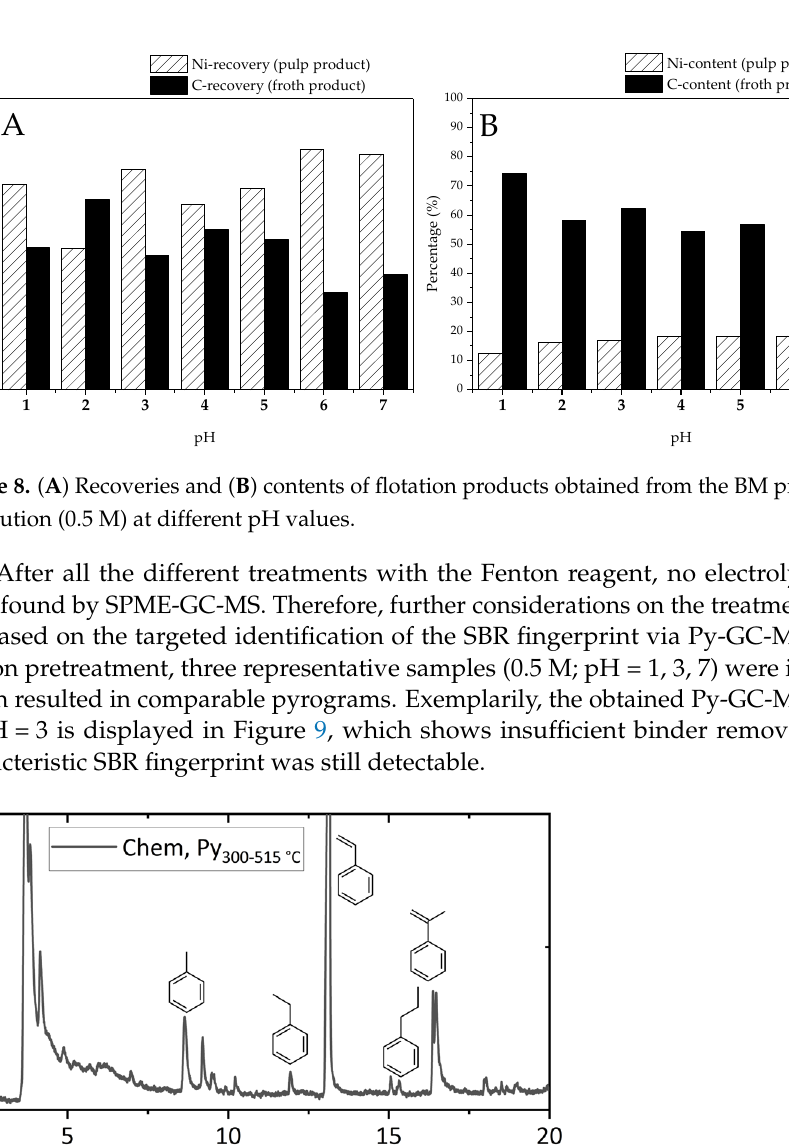
Figure 10. Magnified Py-GC-MS pyrograms of 4 different pyrolysis temperatures (200, 300, 450, and 515 °C) of the BM after roasting at 450 °C for 30 min. After that, flotation experiments were performed on three samples that were ob- tained after different roasting times. By looking at Figure 11A,B, it is apparent that the flotation effect after roasting for 60 min was better than those with roasting times of 30 and 45 min. The graphite recovery in the froth product was 76%, and the NMC recovery in the pulp product was 90%.